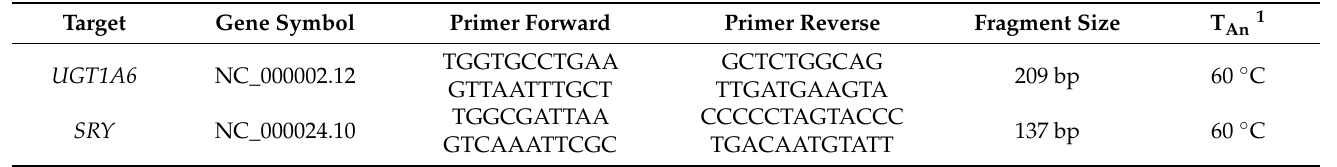
Table 1. Primer details sex-specific polymerase chain